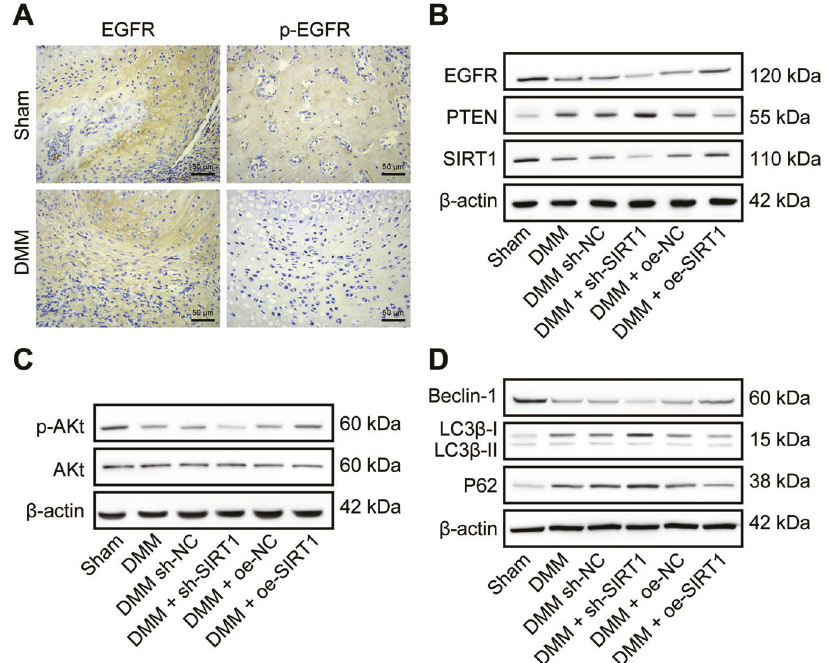
knockdown of SIRT1 and transduction with SIRT1 ( n = 10 mice per